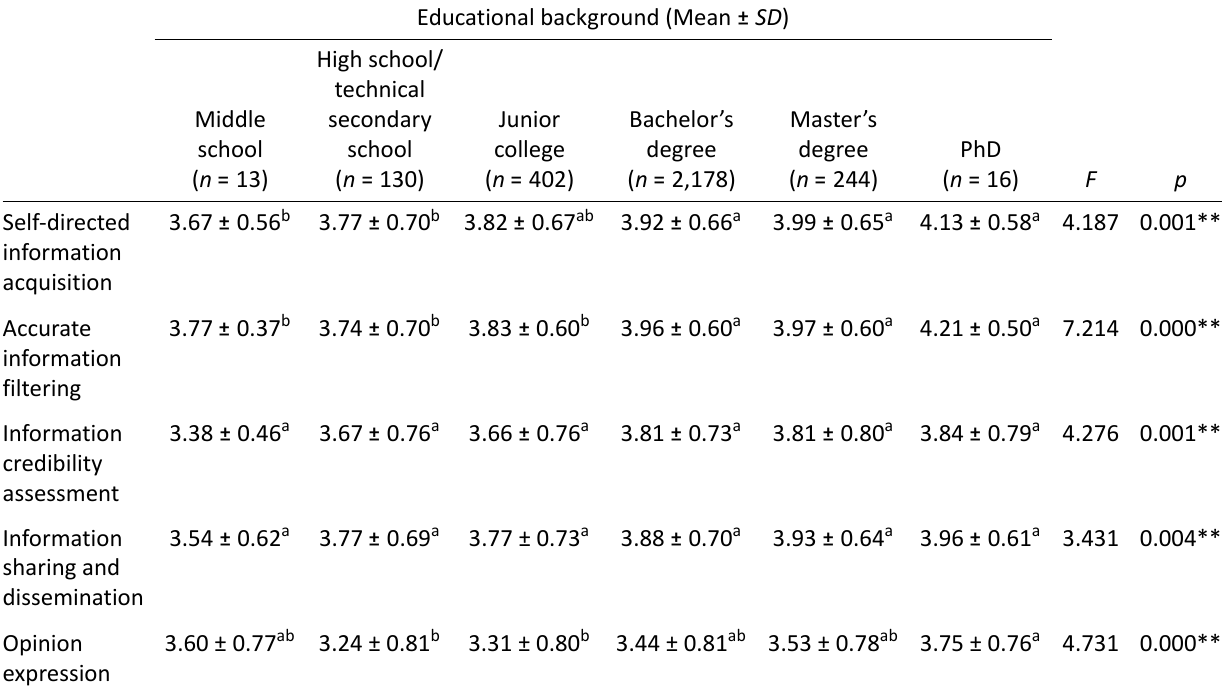
Table 9. Differences in information literacy levels across the educational